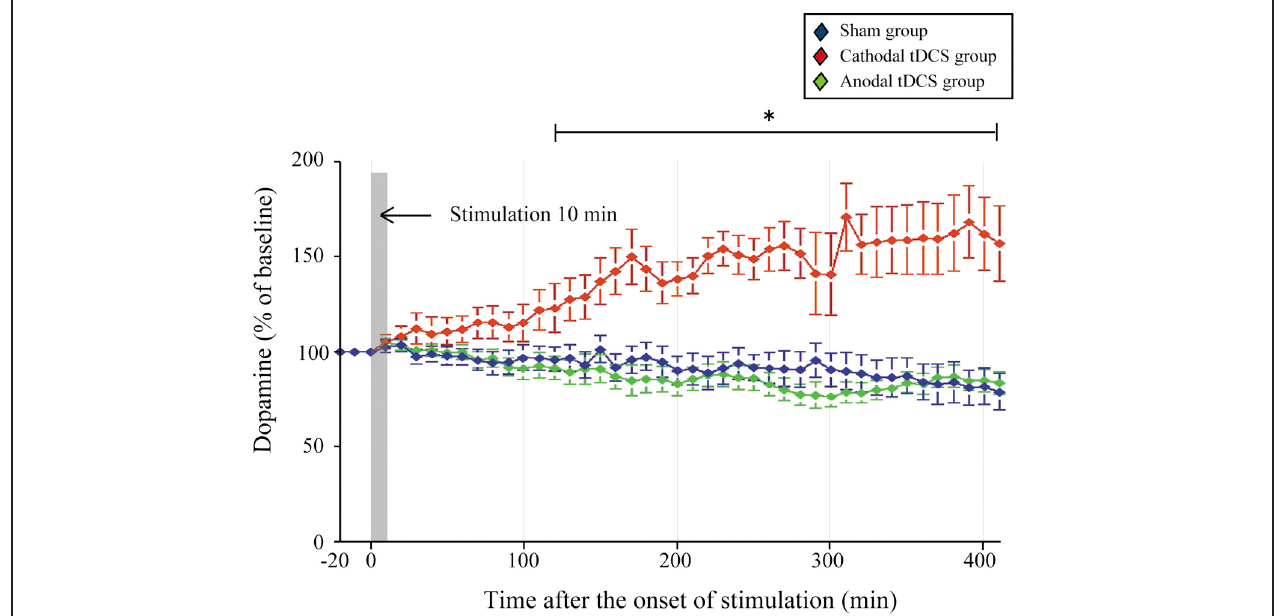
signal changes from baseline values before the tDCS application. Group data are presented as the mean ± SEM . Cathodal, but not anodal, tDCS significantly increased extracellular dopamine levels in the striatum. ∗ p < 0 .